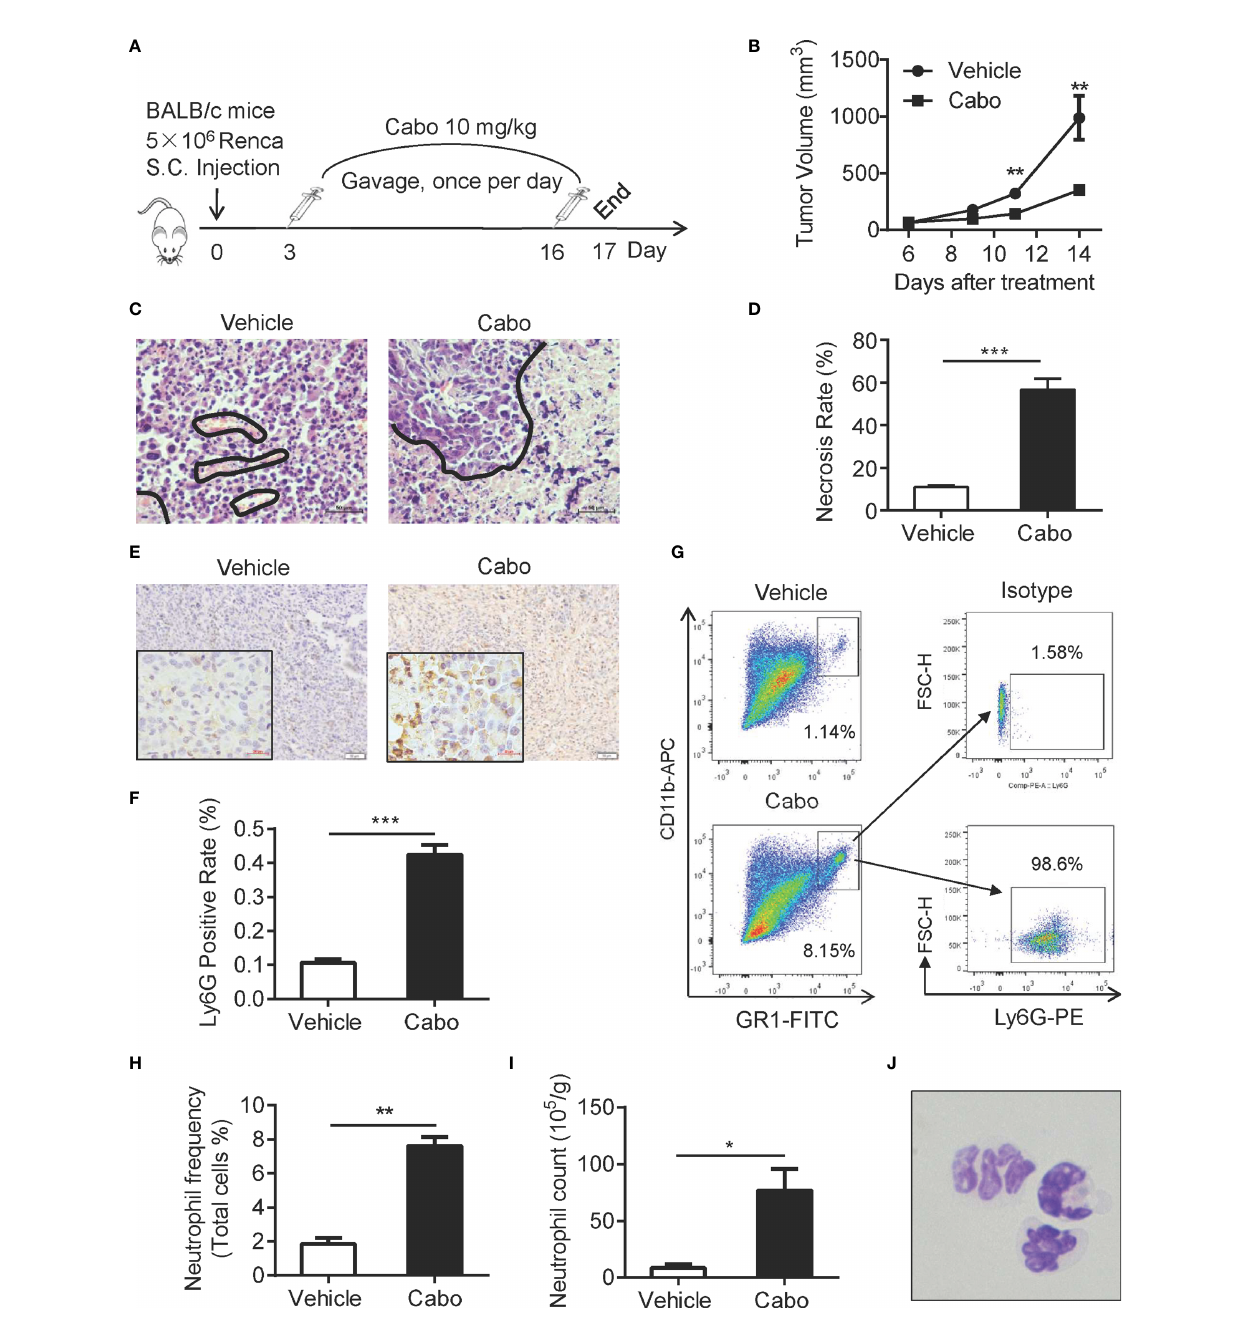
FIGURE 2 | Cabozantinib causes tumor growth inhibition and neutrophil in fi ltration into the tumor bed in a murine model of RCC. (A) Schematic diagram of the experimental design. 5×10 6 Renca cells were subcutaneously inoculated into the right fl ank of BALB/c mice (day 0). On day 3, mice were randomly divided into 2 groups that received cabozantinib (10 mg/kg) or vehicle treatment once per day for 14 days. (B) Tumor growth curves during the experiment. (C, D) Representative results of H&E staining and quantitative analysis of necrotic area in tumor tissues. The area encircled by blue coil indicates necrotic tissue. (E, F) Representative IHC staining (anti-Ly6G, Brown color) and quantitative analysis of Ly6G + cells in tumor tissues. (G) Tumor tissue was homogenized into single cell suspension. 1X10 6 cells were stained with anti-mouse CD45, CD11b and Gr1 and ly6G antibodies, and analyzed by FACS. Representative FACS plots showing the frequencies of CD11b + Gr1 hi cells in cabozantinib- or vehicle-treated tumors (left) and expression of Ly6G on CD11b + Gr1 hi cells. (H) Quantitative analysis of CD11b + Gr1 hi cell frequencies in tumors that received cabozantinib or vehicle treatment. (I) Quantitative analysis results of CD11b + Gr1 hi cell count per gram of tumor tissue. (J) Morphological identi fi cation of CD11b + Gr1 hi cells by Wright-Giemsa staining. Images were taken under 600× magni fi cation. Representative data (Vehicle, n=8; Cabozantinib, n=10) of three independent experiments are shown (Vehicle, n=24; Cabozantinib, n=28 in total) with mean values ± SEM. * P <0.05, *** P <0.001 by unpaired